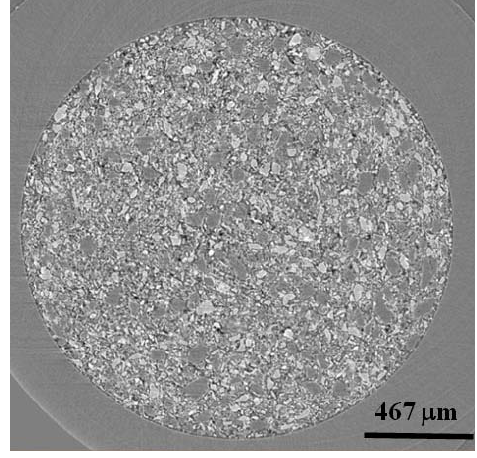
Figure 2. A single x-z oriented slice from 4 mol % TiCl molar ratio. Light contrasting particles are LiBH The black areas are air or void